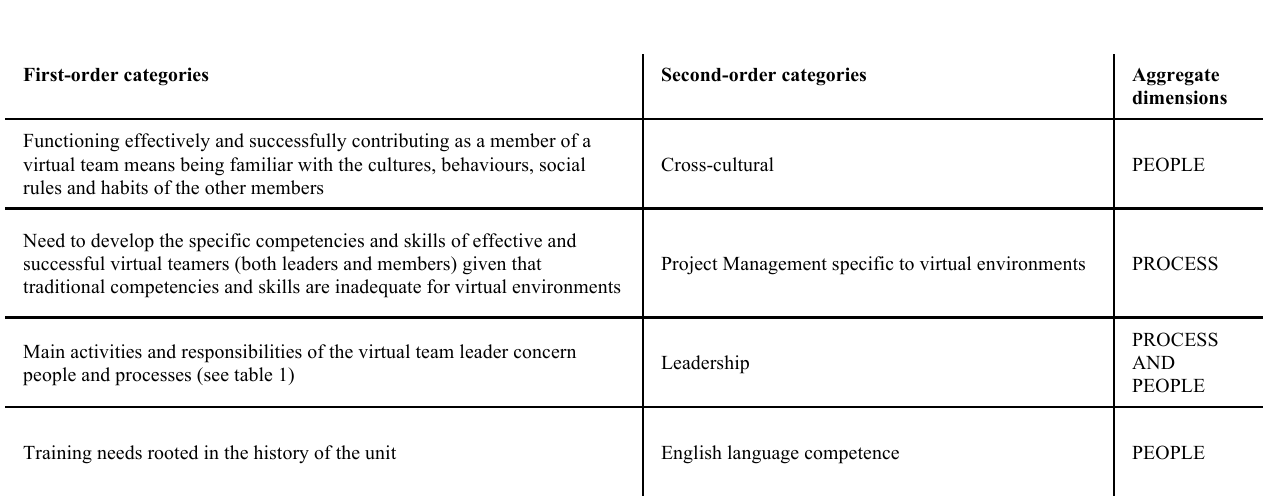
Table 2. The role of formal learning in sustaining effective virtual